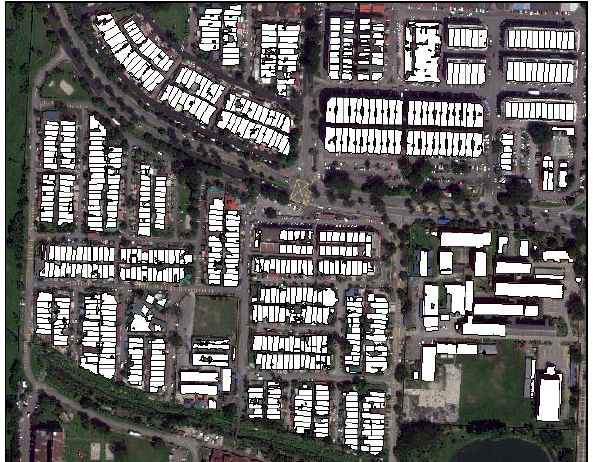
Figure 3: Building footprint at Taman Seri Serdang